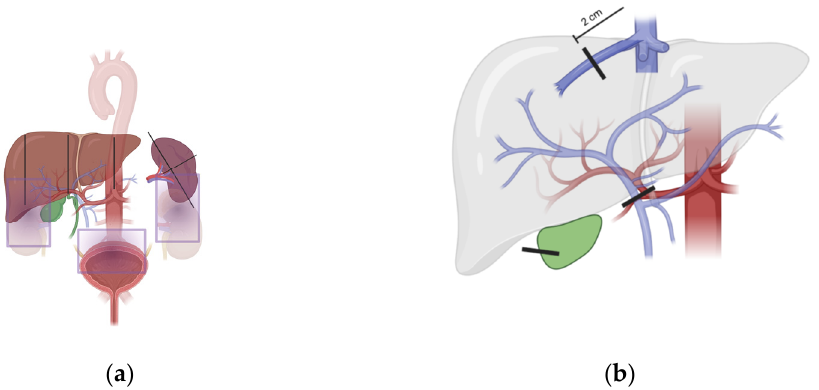
Figure 1. Schematic ultrasound scanning approach. Illustration of all ultrasound scanning axes applied within the SOS ultrasound protocol. Gray boxes represent areas scanned for ascites. Vertical lines show places for measurements as described in the methods section. Images were created with BioRender.com. ( a , b ) for the illustration of all ultrasound scanning views